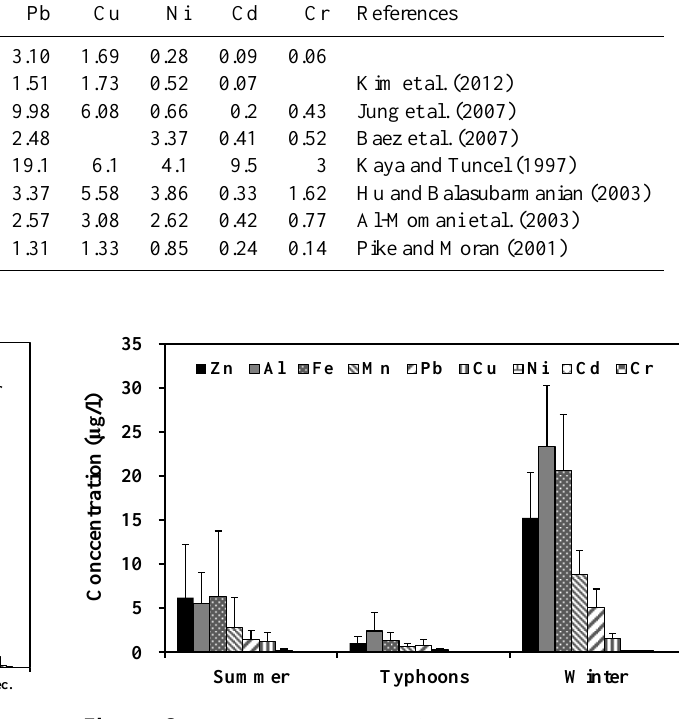
Figure 7. Monthly variation of VWMC of trace metals in rainwater samples during 2012.